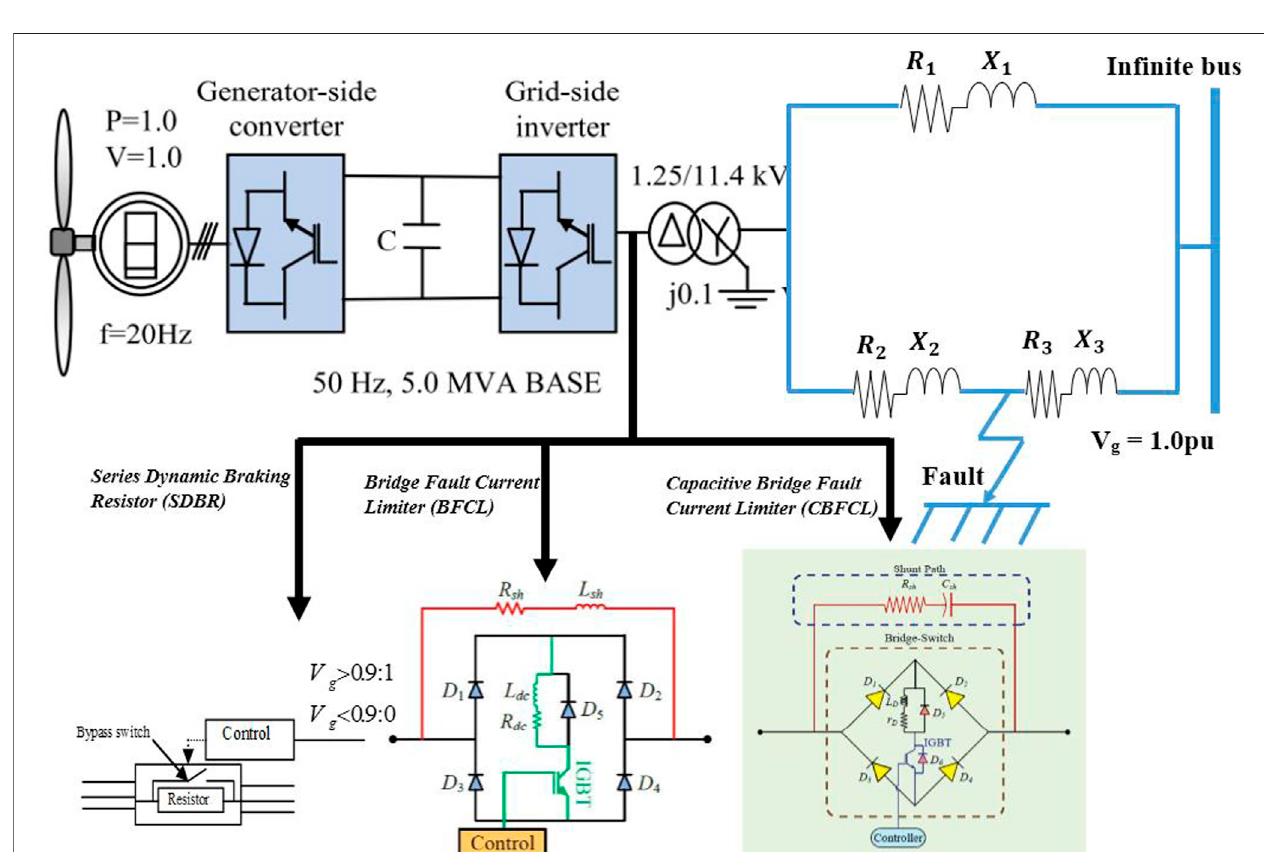
FIGURE 2 | PMSG wind turbine with different fault current limiters.